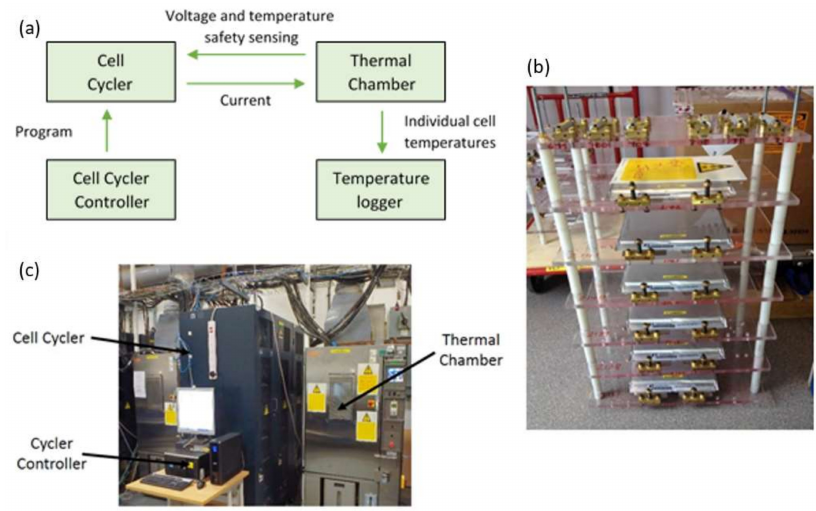
Figure 1. ( a ) Schematic representation of the experimental set-up; ( b ) Photograph of the cell mounting fixture; ( c ) Photograph of the experimental set-up.